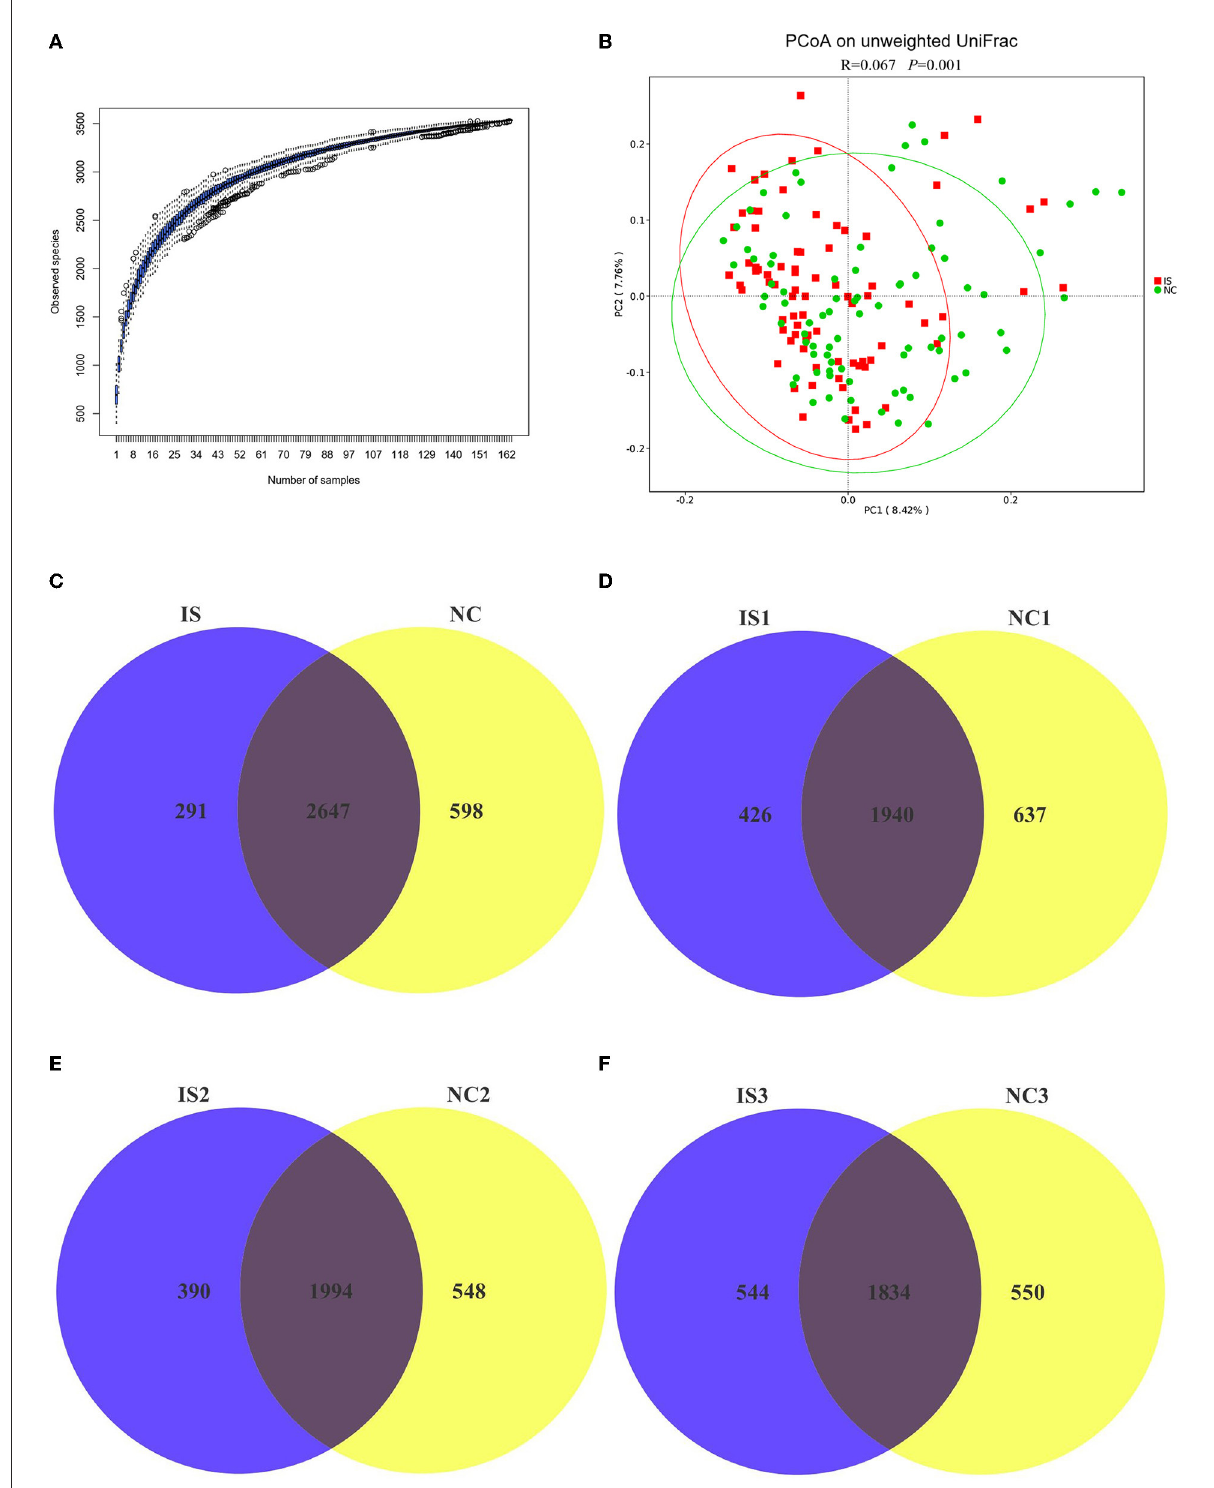
FIGURE1 The differences of OTUs between normal controls (NCs) and ischemic stroke (IS) patients in the entire population and for each ethnic people (Tujia, Miao, and Han) according to the 16S rRNA data. The IS patients of the Tujia, Miao, and Han people were indicated with IS1, IS2, and IS3, respectively. The NCs of the Tujia, Miao, and Han people were indicated with NC1, NC2, and NC3, respectively. (A) Species accumulation boxplot of the entire population. (B) Principal coordinate analysis (PCoA) of the microbiota based on the unweighted UniFrac distance metrics for NCs and IS patients. ANOSIM, R = 0.067, P = 0.001. (C–F) Venn diagram of the observed OTUs in NCs and IS patients in the entire population and for each ethnic people (Tujia, Miao, and